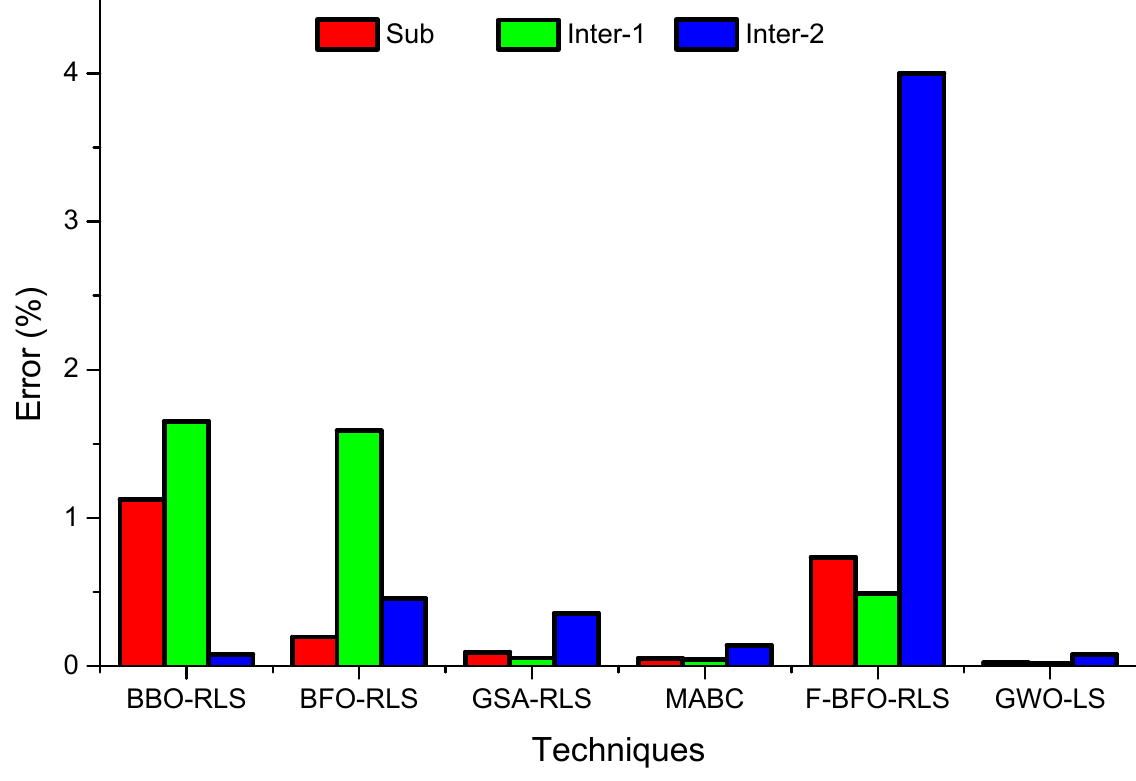
Figure 19. Comparison of amplitudes erros for case study II.